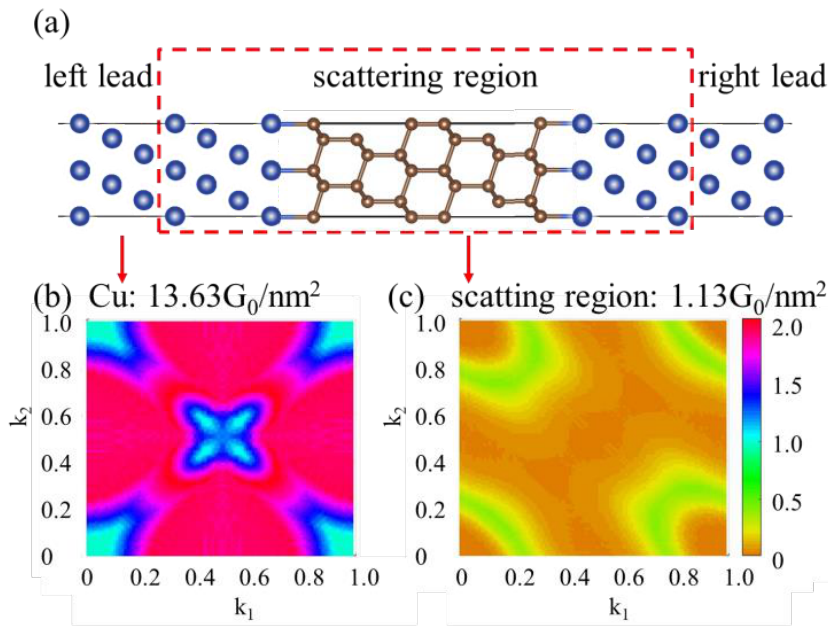
Figure 7. ( a ) Side view of the atomic structure of the diamond/Cu interfaces in NEGF-based electronic transport calculations. The dashed red line delimits the simulation box for the ab initio transport calculations; periodic boundary conditions are applied in the plane perpendicular to transport. ( b , c ) present the transmission coefficients (averaged on energy) in reciprocal space of pure Cu and diamond/Cu interfaces respectively, as well as the total conductance per unit